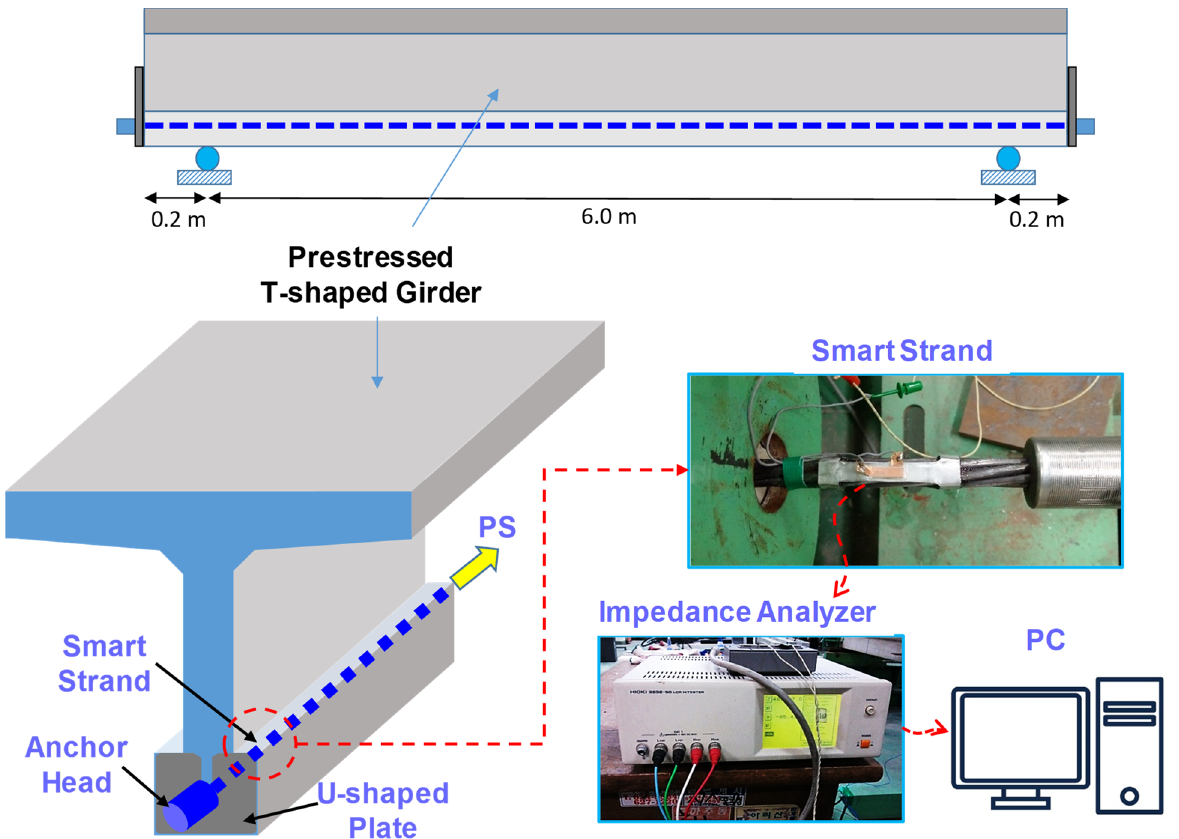
Figure 6. The test structure and its experimental setup [2].